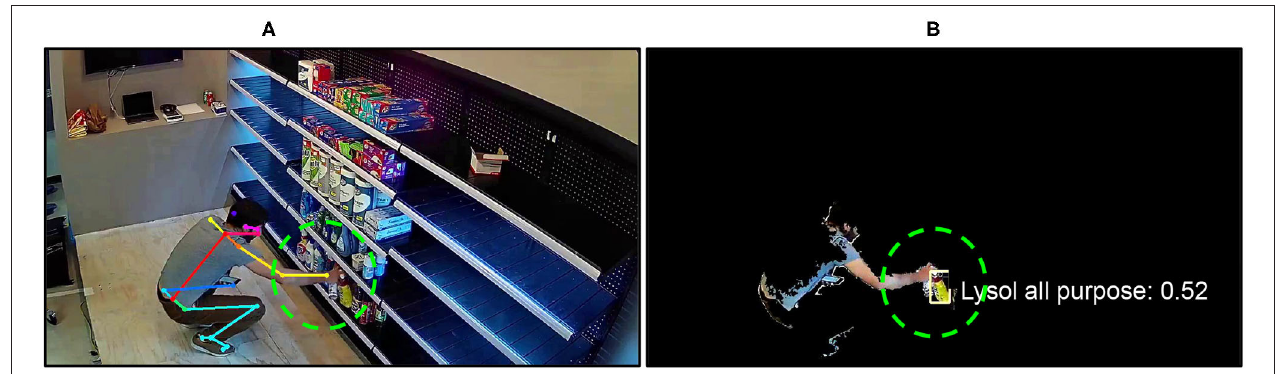
FIGURE 4 | Human pose estimation provides us an estimate of the location of the customer’s hand, where the visual classifier will look for items (A) . We also apply background subtraction to the original image to remove detected items present around the hand (B) , such as the objects remaining on the